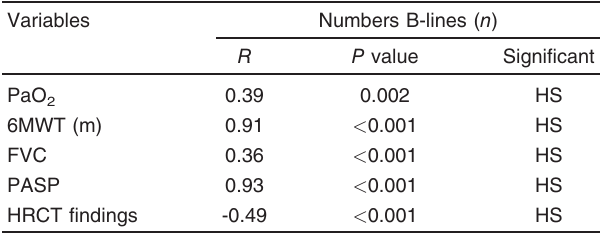
Table 5 Correlation between numbers of B-lines with other variables among cases Variables